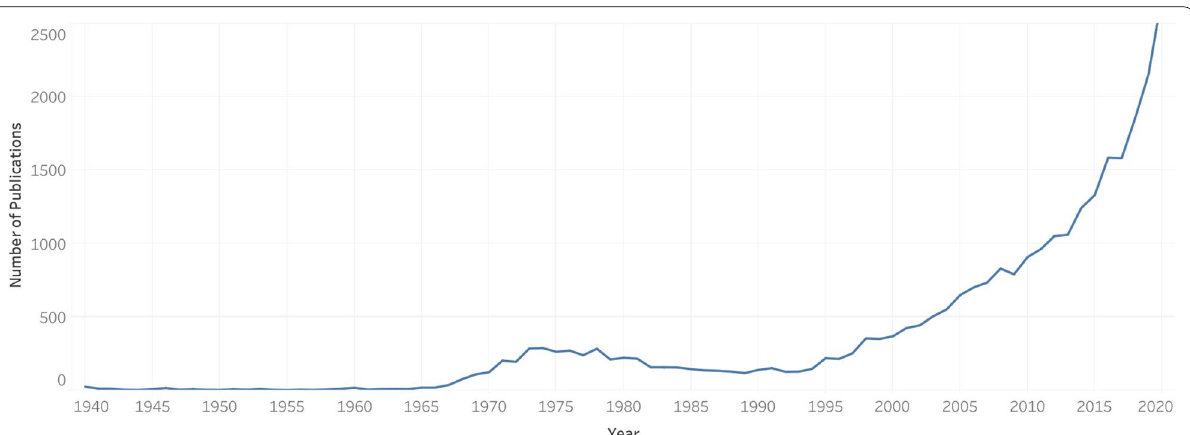
Fig. 1 Number of cannabis and cannabinoid publications per year from 1940 to 2020. Data was collected from Scopus in a single search. The year 2021 was omitted due to the year being incomplete at the time the search was